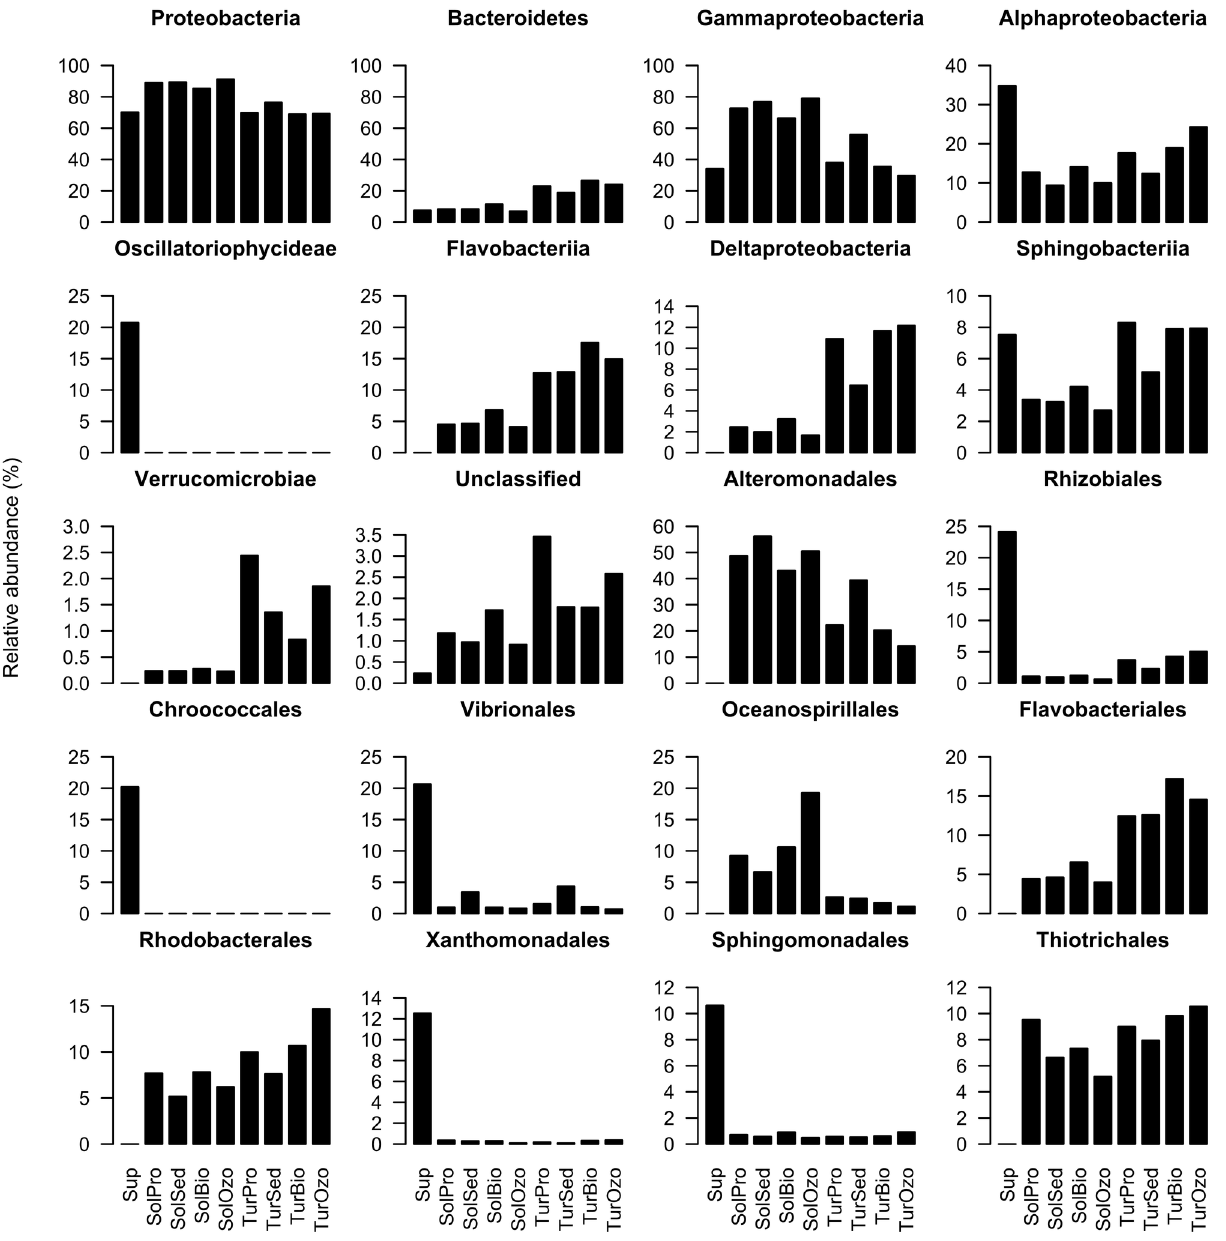
Figure 5. Dominant bacterial groups. Relative abundance of the most dominant bacterial groups (2 phyla, 8 classes and 10 orders) in each sampling compartments (water supply (Sup), turbot production tank (TurPro), turbot sedimentation tank (TurSed), turbot biofilter tank (TurBio), turbot ozone tank (TurOzo), sole production tank (SolPro), sole sedimentation tank (SolSed), sole biofilter tank (SolBio), sole ozone tank (SolOzo)). Groups are present from the most abundant to the least abundant.